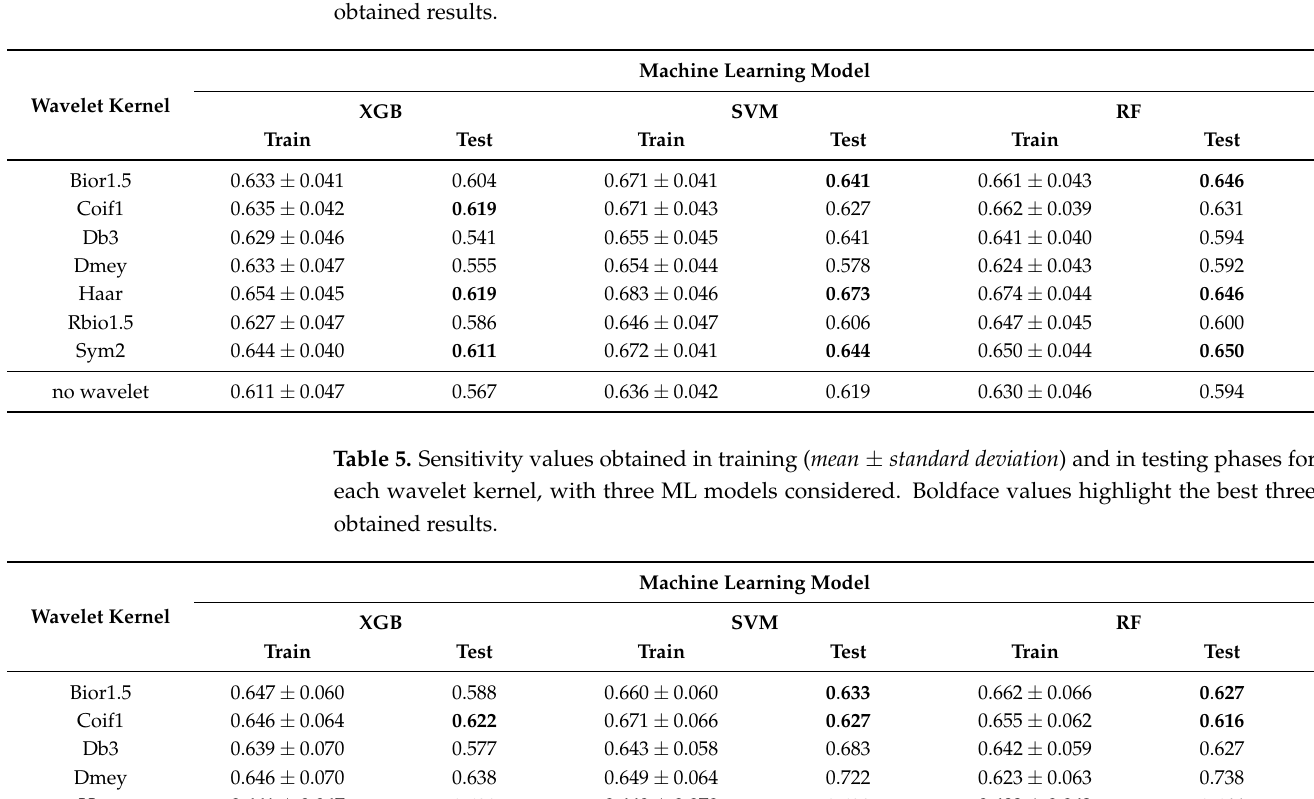
Table 4. Accuracy values obtained in training ( mean ± standard deviation ) and in testing phases for each wavelet kernel, with three ML models considered. Boldface values highlight the best three obtained results.